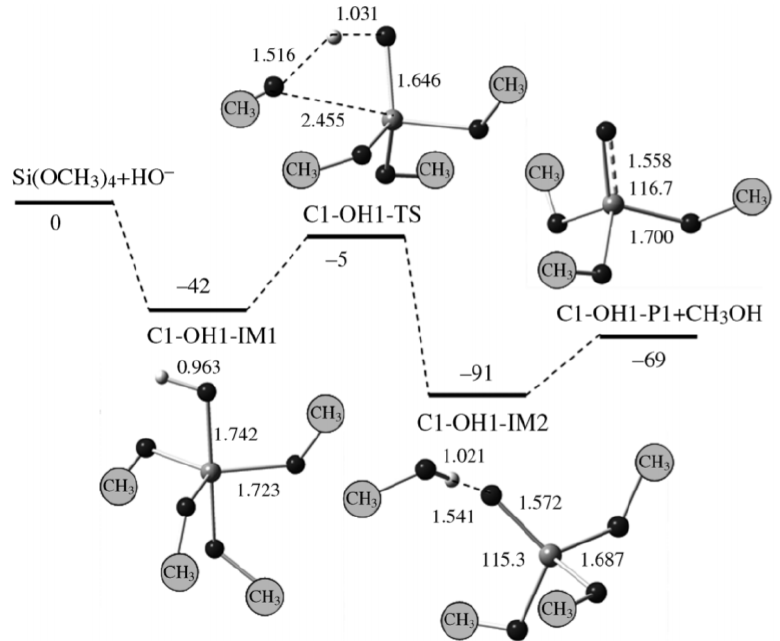
Figure 27. Propyl ethoxy silane (PES) of the first order hydrolysis of TMOS in an alkaline medium. Reprinted with permission from [35]. Copyright John Wiley and Sons, 2012. Reprinted with permission from [35]. Copyright John Wiley and Sons,